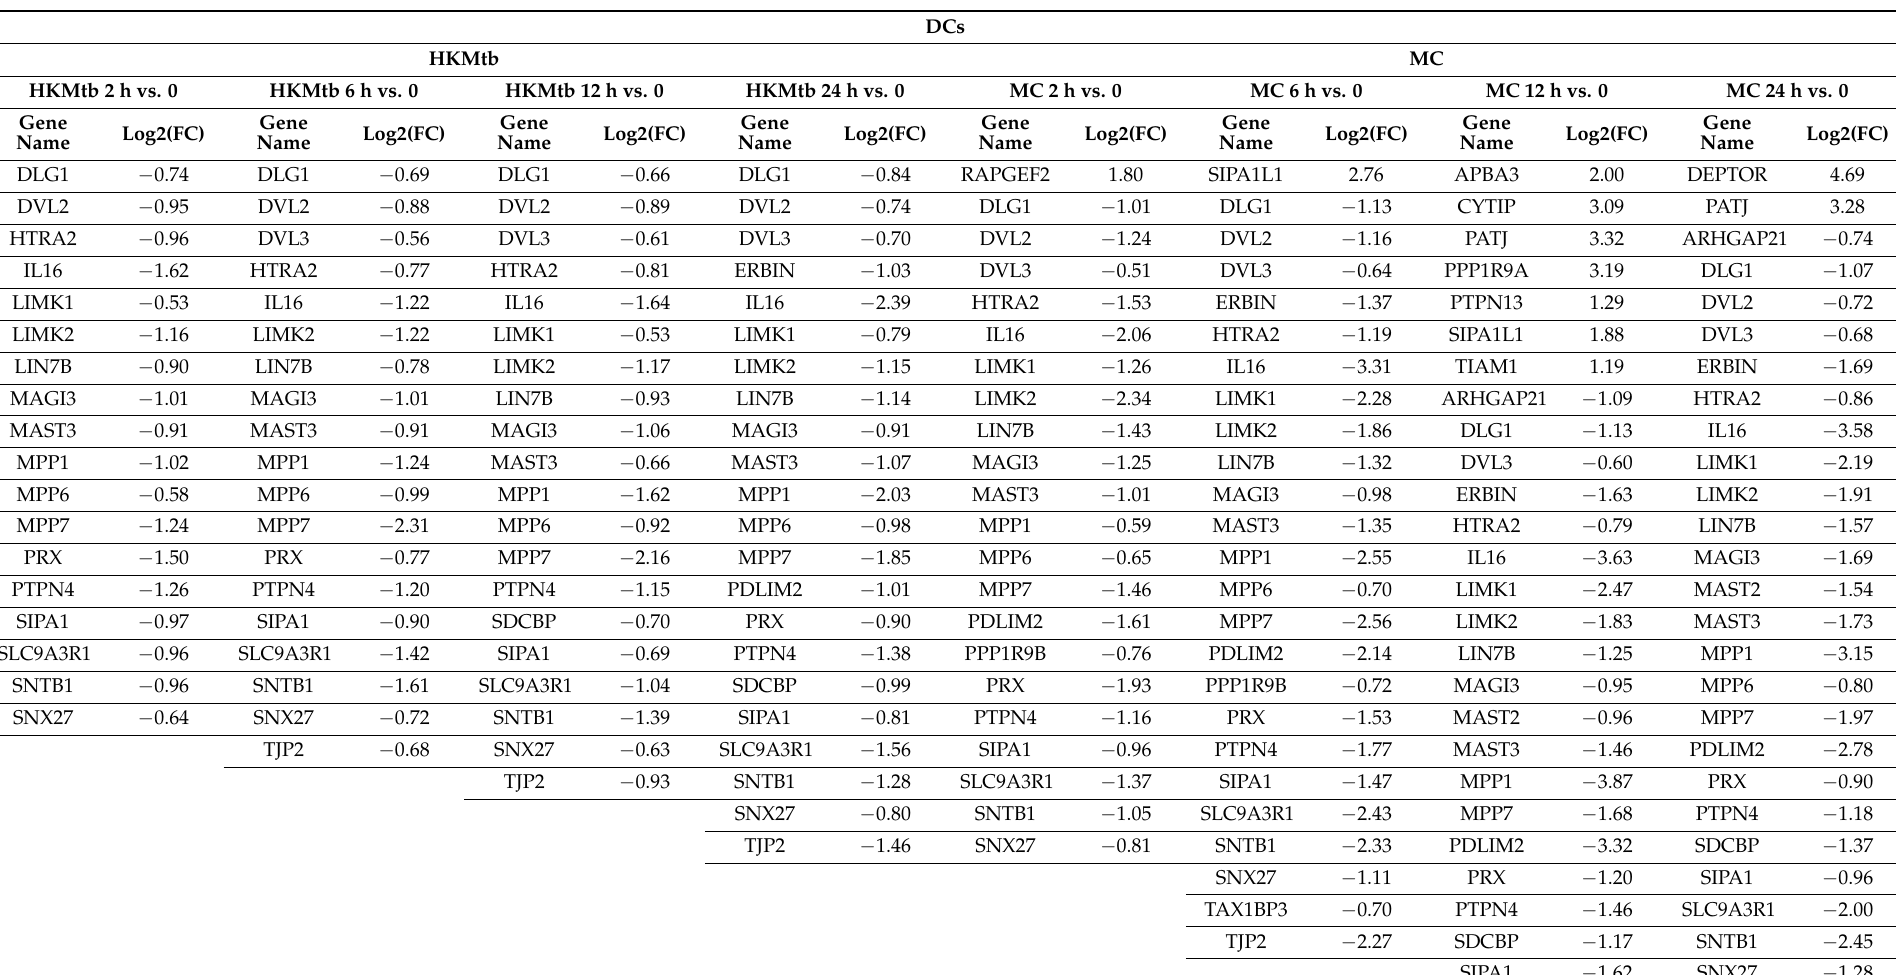
Table 2. PDZ DEGs in DCs stimulated with HKMtb and MC. Gene expression level (log2 mean fold change) subjected to one-way ANOVA with a Dunnett’s test. Statistical significance was set at p <